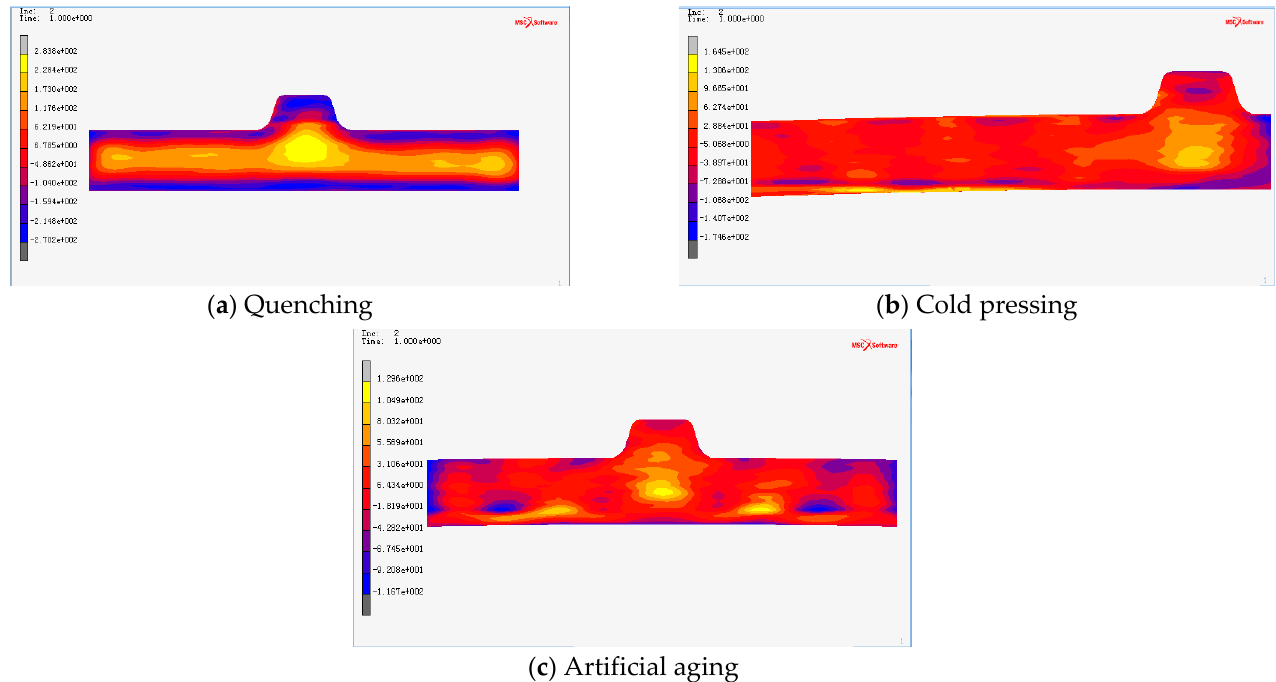
Figure 11. Longitudinal residual stress distribution of the cutting surface after different processes: ( a ) quenching; ( b ) stepwise cold pressing; ( c ) artificial aging.